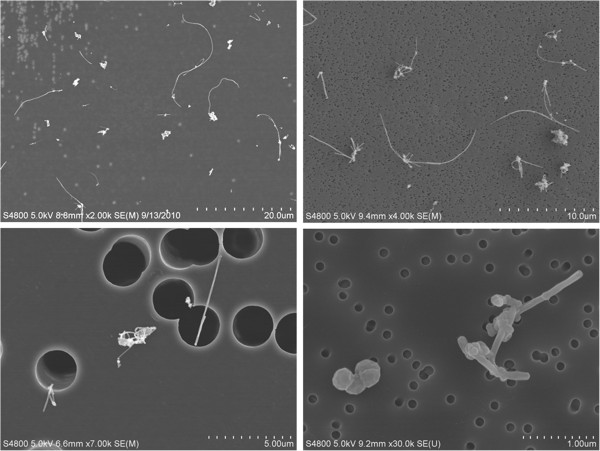
Images of multi-walled carbon nanotubes (MWCNT) from the rodent inhalation study. Scanning electron microscopy images of MWCNT collected on the most populated stage of a Nano MOUDI, showing a well-dispersed material. The images represent four different magnifications indicated by the scale bars (20, 10, 5, and 1 um). The 5 μm scale bar had a pore size (dark circles) of 2.5 μm and the other three figures had a pore size of 0.1 μm. The mass median aerodynamic diameter of the material was 1.5 μm. The count mode aerodynamic diameter was ~400 nm.